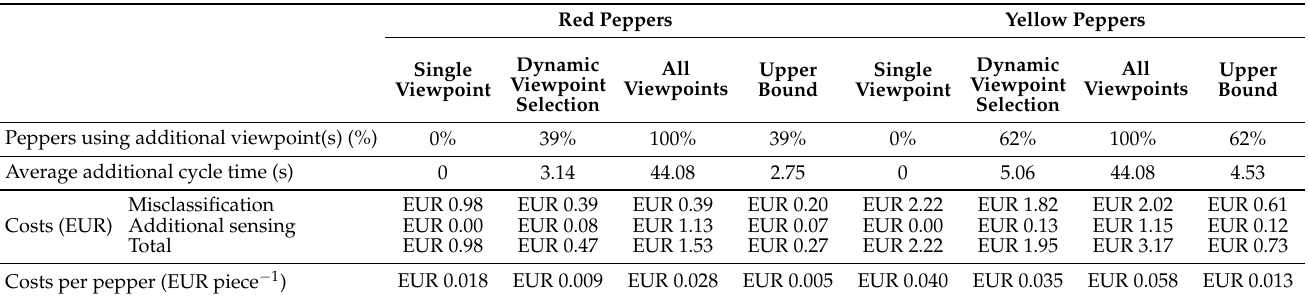
Table 4. Percentage of classifications using more than one viewpoint, the additional cycle time, the total associated costs and associated costs per pepper for the single viewpoint, the dynamic viewpoint selection method, all viewpoints, and upper bound.